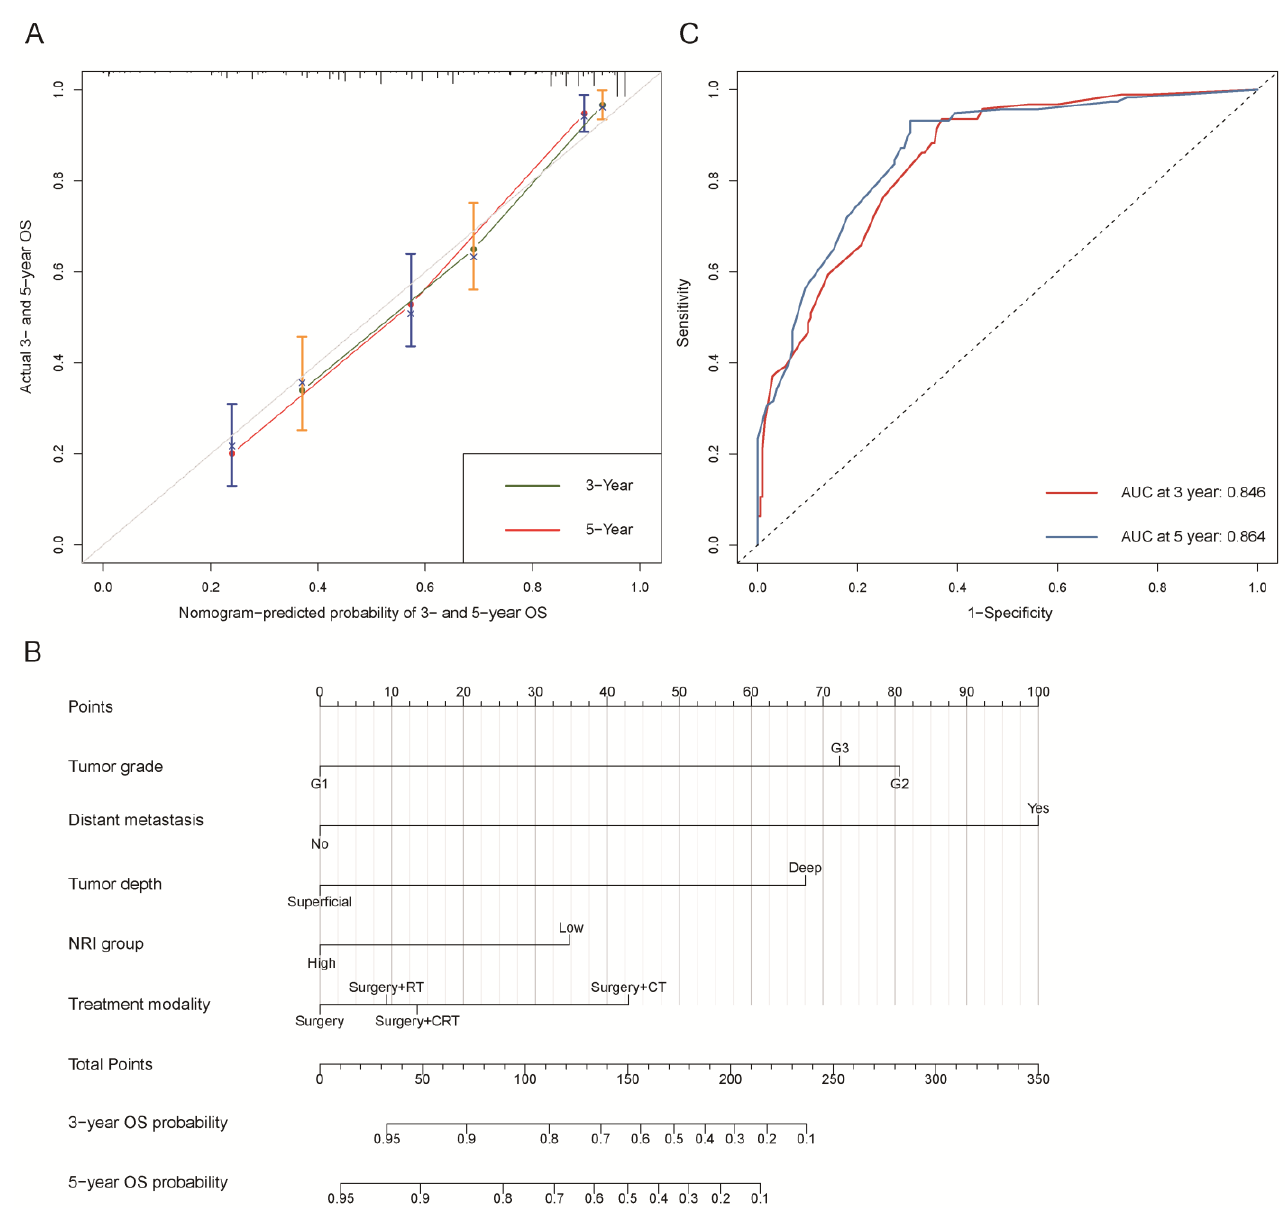
Figure 2. Overall survival (OS). ( A ) Calibration plot of OS at 3- and 5-year. ( B ) Nomogram for predicting the probability of OS at 3- and 5-year. ( C ) Predictive performance of nomogram for OS at 3-year and 5-year, by time-dependent receiver operating characteristic (ROC) curve analysis. The nomogram was constructed by tumor grade, distant metastasis, tumor depth, NRI group, and treatment modality. CT: chemotherapy; RT: radiotherapy; CRT: chemoradiotherapy; NRI group: low group (NRI ≤ 99.34) and high group (NRI >